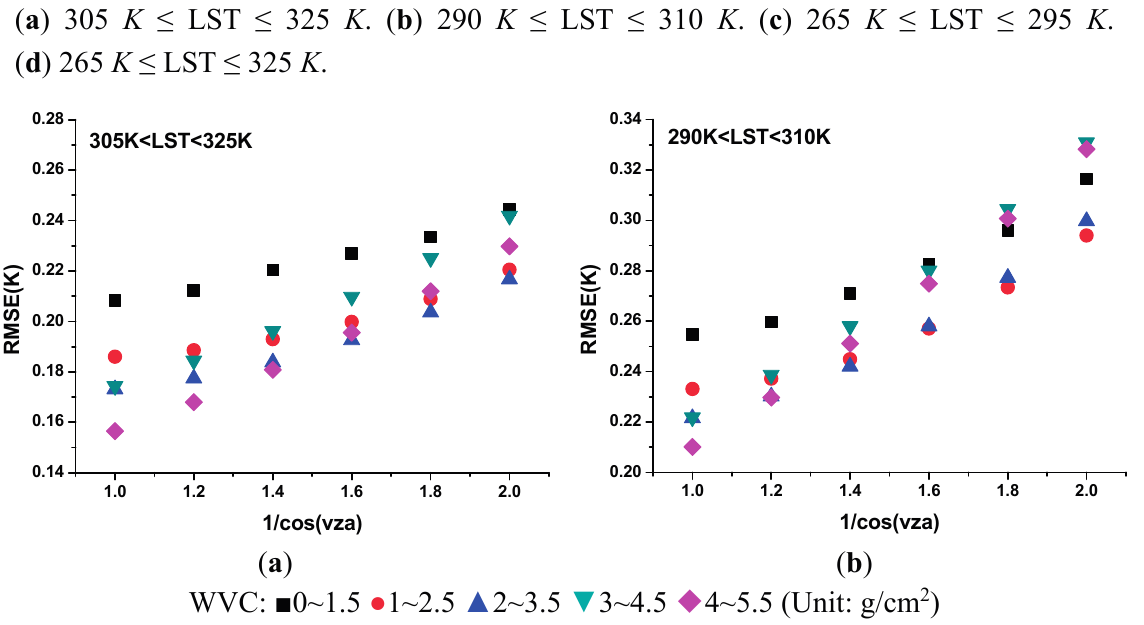
Figure 6. RMSEs between the actual and estimated LST for different